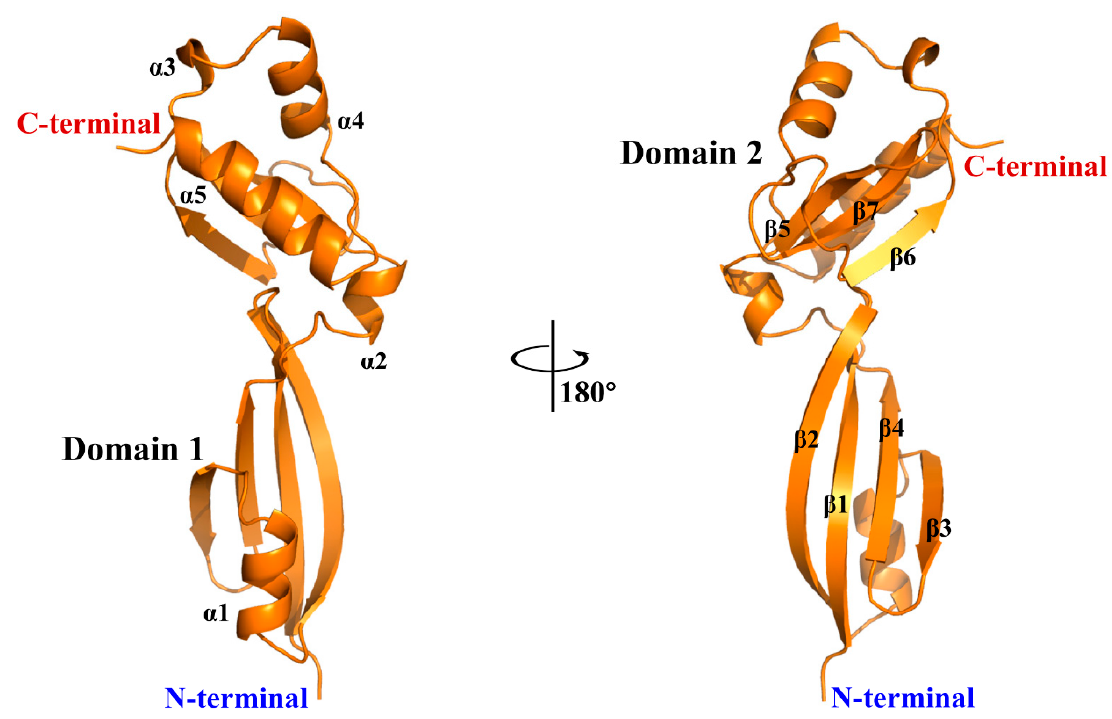
Figure 2. Two views of a simulated representation of rBofC. There are two domains including seven β -strands ( β 1– β 7) and five α -helices ( α 1– α 5). Table 1. X-ray data collection and model refinement statistics for rBofC crystal. Crystal